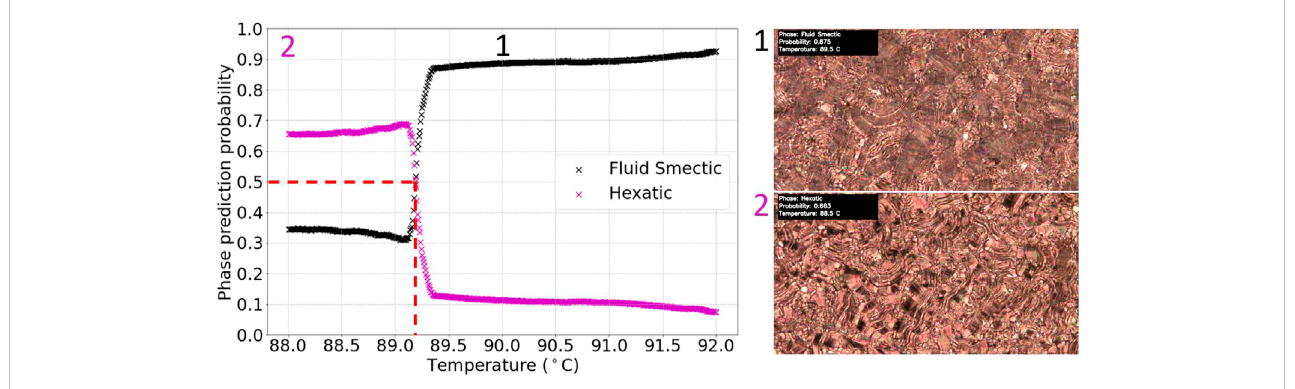
FIGURE 9 Graph of phase prediction probability against temperature for a labelled chiral fl uid to hexatic (SmC*-SmI*) transition test video. The vertical dashed line shows the identi fi ed transition temperature. The fi gure shows the accurately labelled test video (in contrast to the incorrectly labelled ones further below in Figure 10).